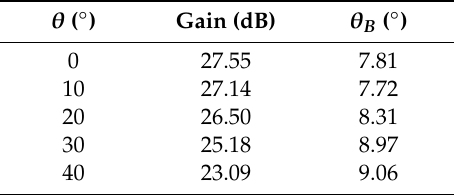
Table 8. Simulation results of Figure 14. Feed position arrangement.